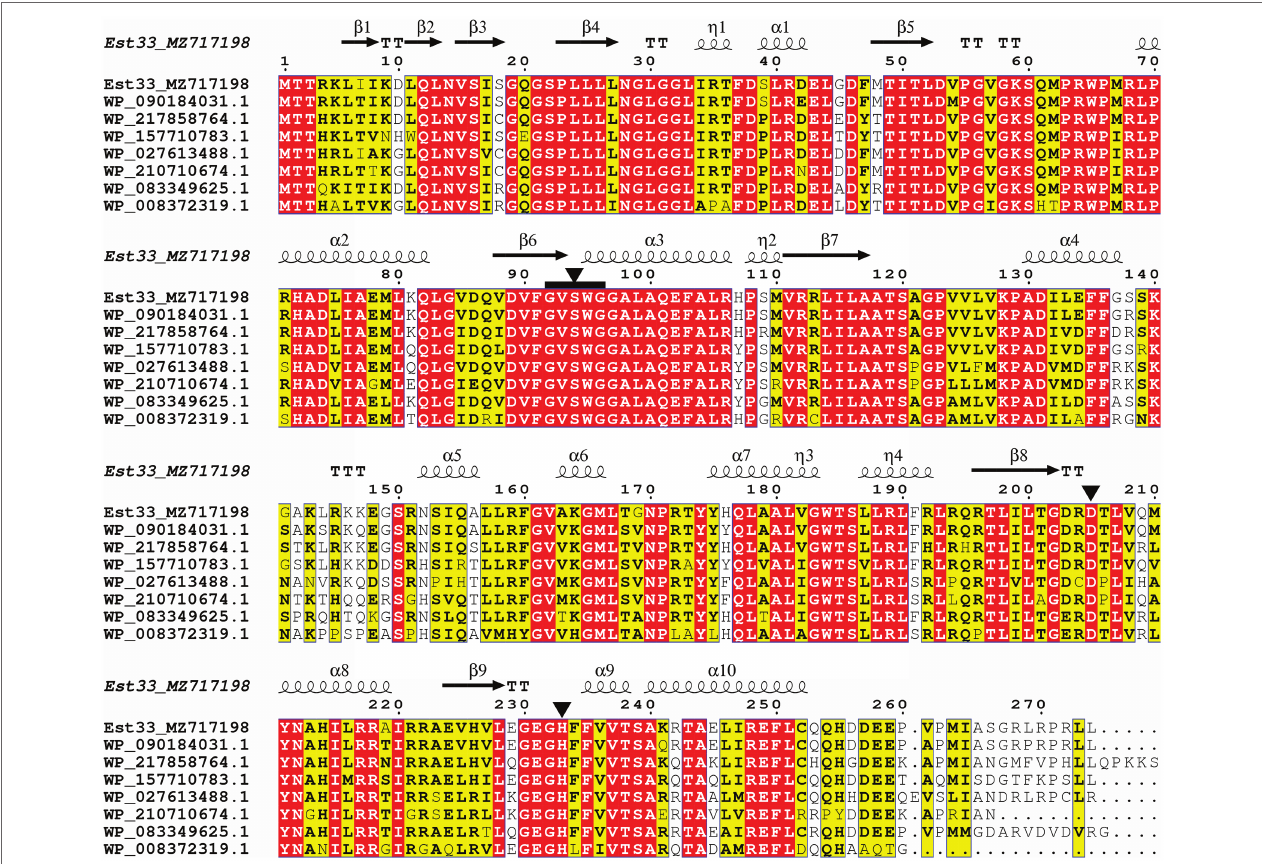
FIGURE 1 | Sequence alignment of Est33 and its homologs. White letters on a red background indicate identical residues, while black bold characters and yellow box indicate similar residues. Secondary structures of Est33 are shown above the alignment. Helices, strands, turns, and 3 10 helices are indicated by springs, arrows, TT letters, and η letters, respectively. Residues forming the catalytic triad Ser, Asp., and His black are marked by triangle. The conserved pentapeptides GXSXG are marked by black squares. The amino acid sequences used were α / β hydrolases annotated from P. arsenicoxydans , P. sp. SWRI79, P. sp. PB120, P. umsongensis , P. sp. URIL14HWK12:I6, P. koreensis , and P. sp. M47T1, and the identity with Est33 is 94.5%, 86.5%, 81.4%, 77.7%, 74.8%, 82.9%, and 72.9%,